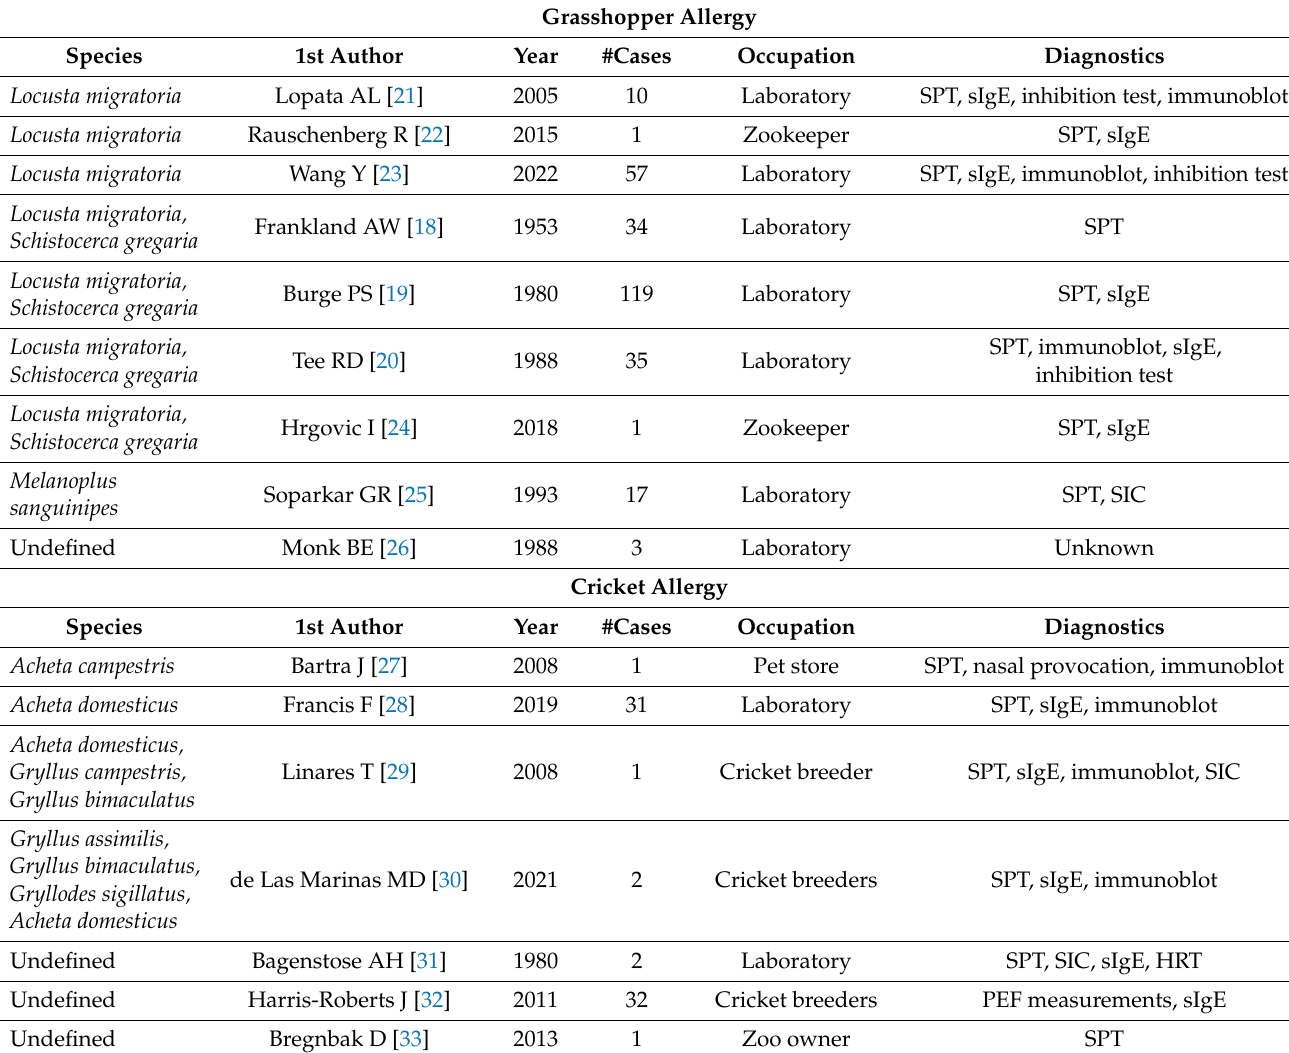
Table 1. Orthoptera allergy. Grasshopper